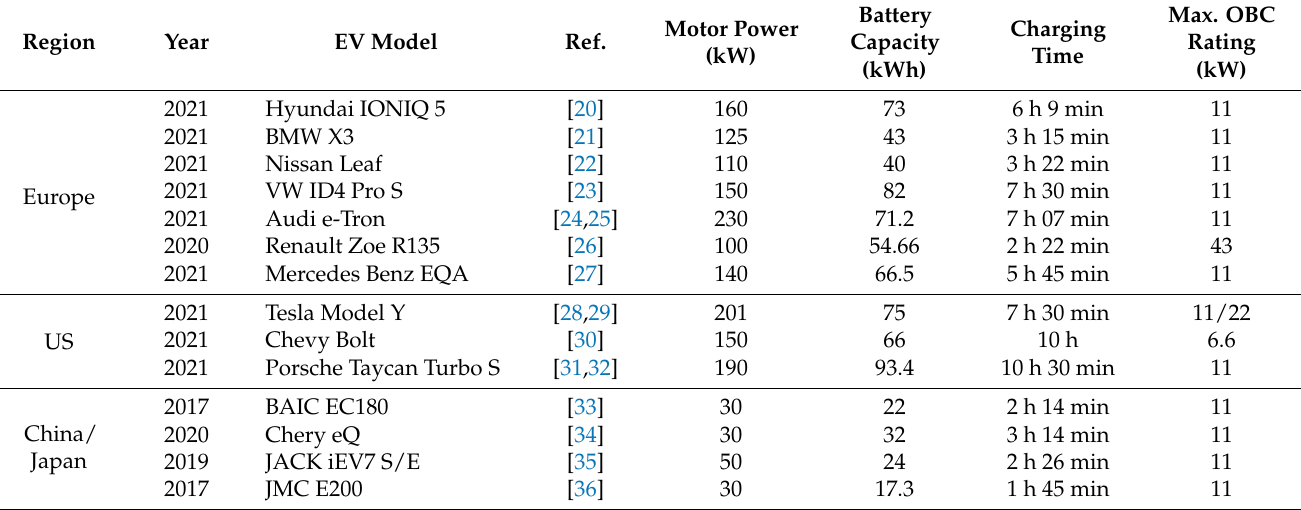
Table 1. Electric powertrain specification of commercially available EVs.